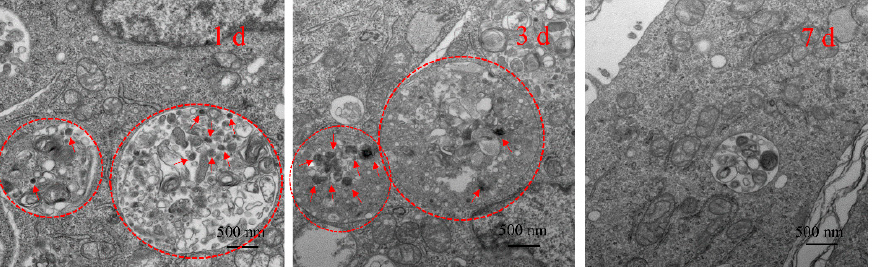
Figure 8. Bio-TEM images of intracellular biodegradation for MSCNs culturing with 4T1 cells for 1, 3 and 7 d.